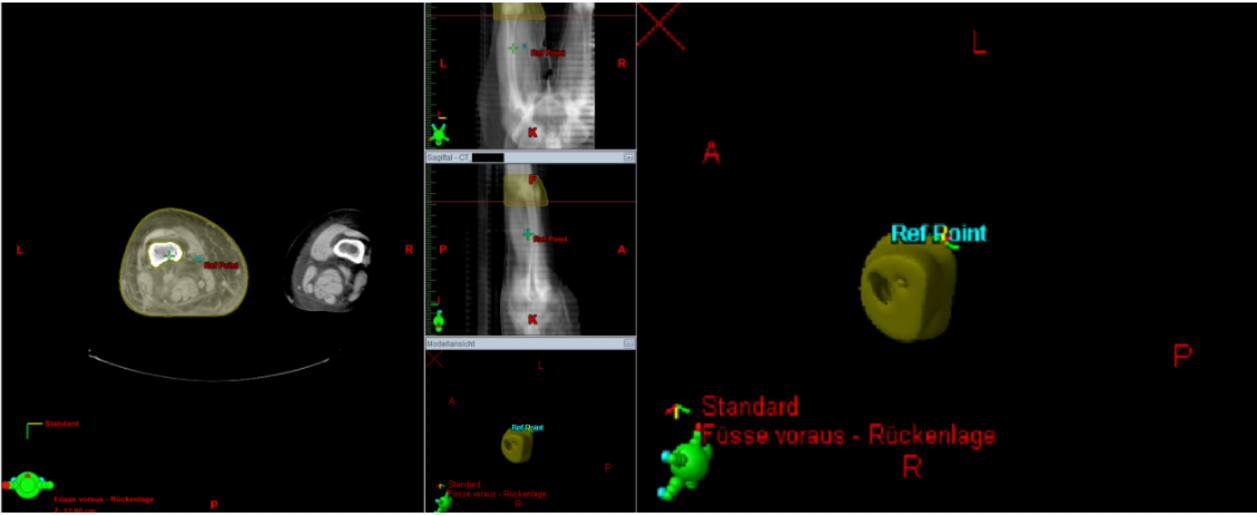
Figure 5. Contouring the area of the narrow lymph-sparing volume with 10 cm